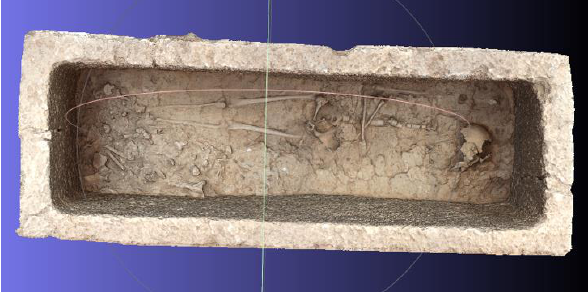
Figure 1. The printable coffin, the site of Capo Don ‘ Costa Balenae ’.